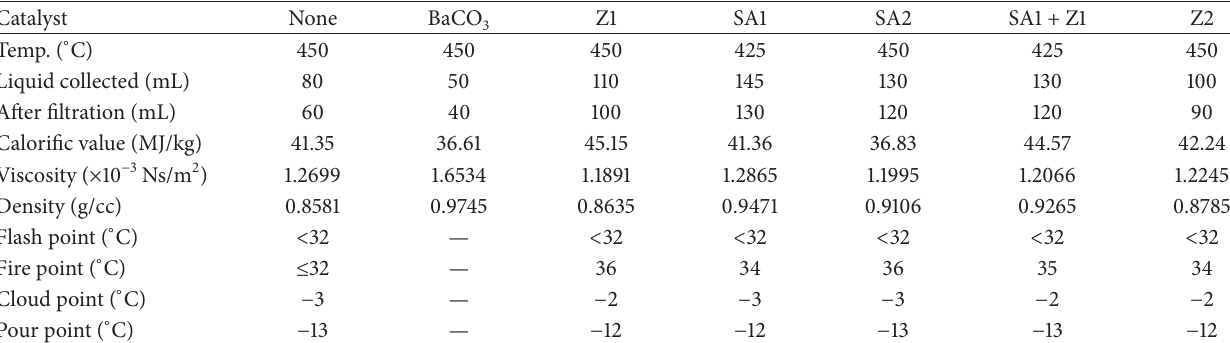
Table 2: Optimum properties of plastic oil with different